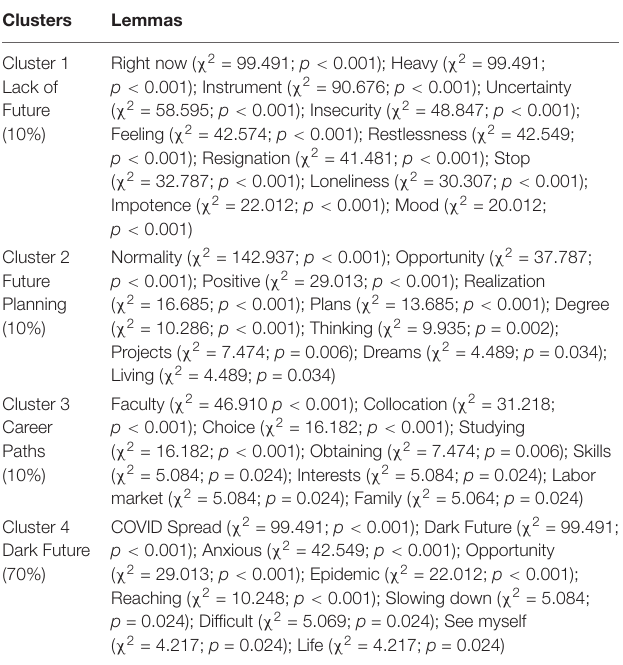
TABLE 1 | Clusters, associated lemmas, χ 2 values, and significance. Clusters